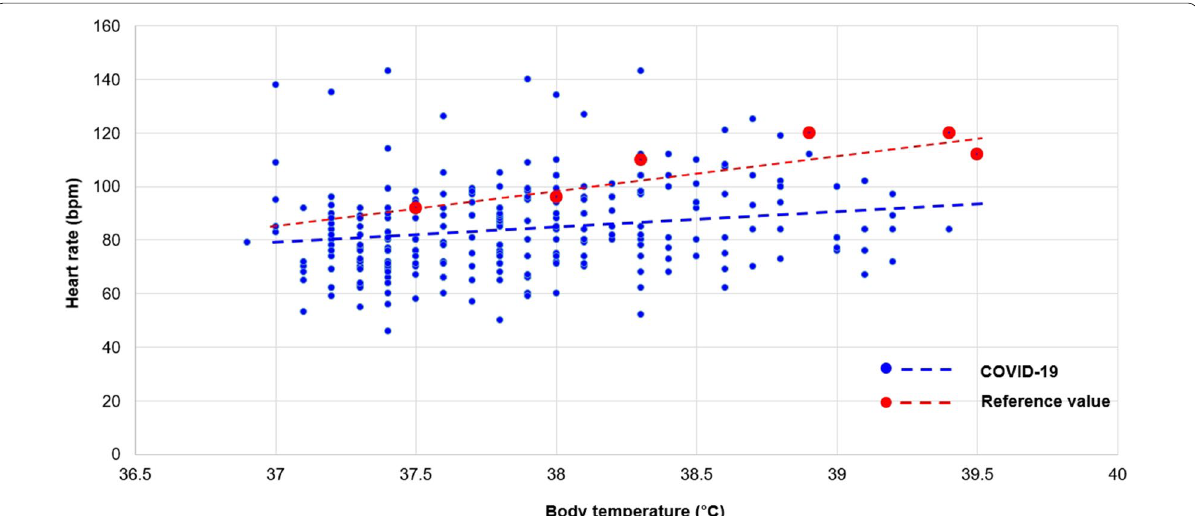
Fig. 2 Temperature–heart rate relationship in patients with COVID‑19 at peak temperatures (red spot and line: reference value (General relationship in infectious disease) adopted from Emerging infectious diseases 2007;13:650 . and infect Dis practice 1997;21:38–40